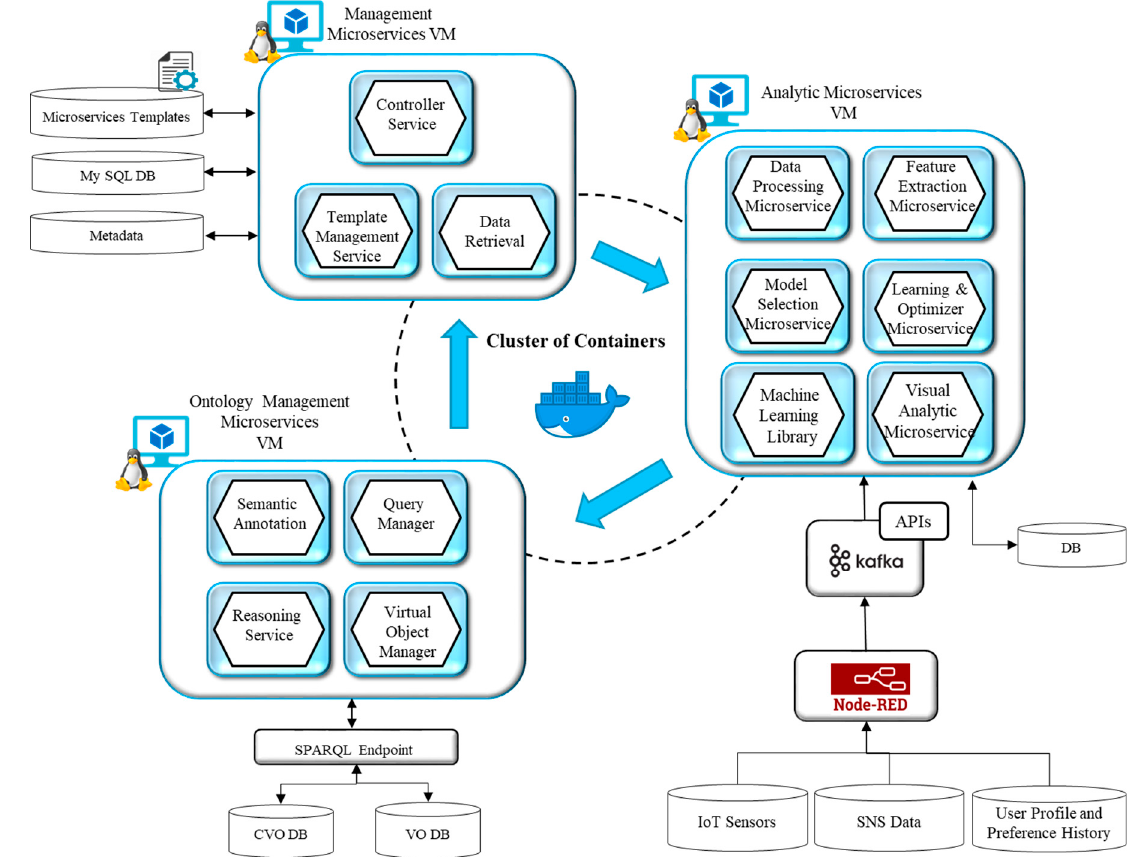
Figure 12. The prototype implementation system settings. Figure 122. The prototype implementation system settings. Figure 122. The prototype implementation system settings.